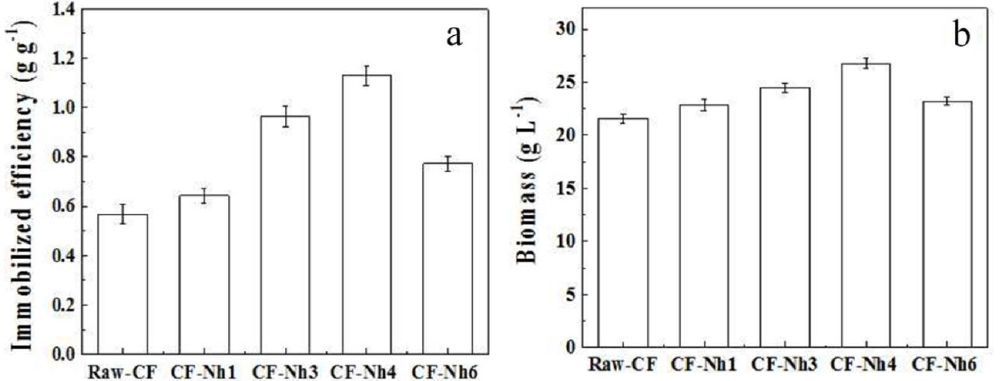
Figure 4. Effects of oxidation carriers on immobilized efficiency (IE) and biomass of fermentation ( a ) Effects of oxidation carriers on the IE; ( b ) Effects of oxidation carriers on the biomass of fermentation. Biomass was calculated using the amount of free cells and immobilized cells in the third fermentation by immobilized C. tropicalis on CF with and without treatment. Results represent the average of two independent experiments conducted with three replicates for each condition.